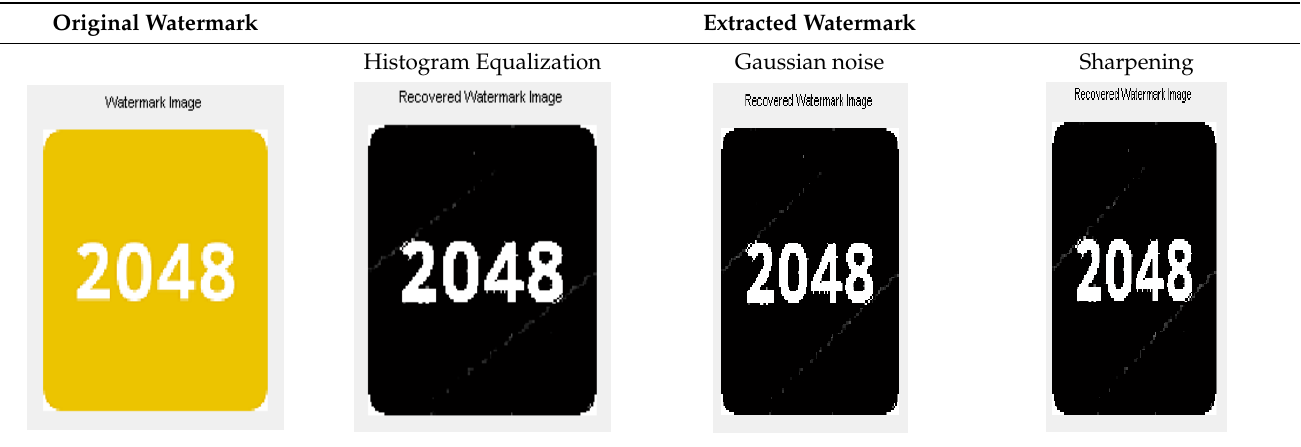
Table 5. Comparison of extracted watermark with original watermark of size 128 × 128.